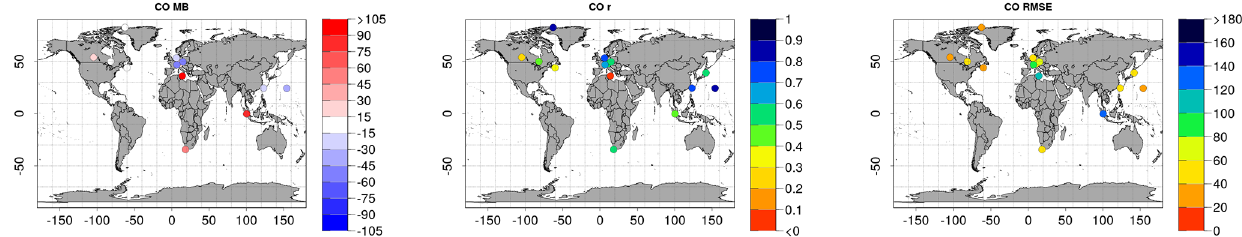
Figure 4. CO spatial distribution of mean bias (MB, ppb) (left panel), correlation ( r ) (middle panel) and root mean square error (RMSE, ppb) (right panel) at all the rural WDCGG stations